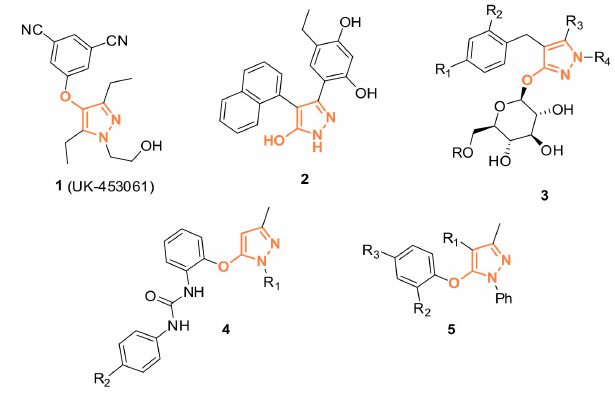
Figure 1. Examples of hydroxy-pyrazole derivatives described in